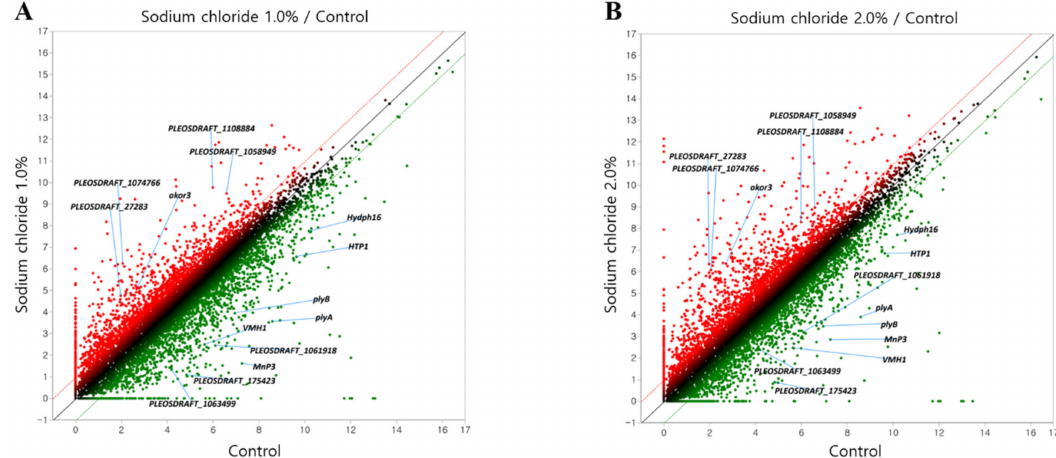
Figure 3. ( A ) DEG scatter plot analysis of control and NaCl 1.0% condition of Pleurotus ostreatus , red, 4-fold change over; green, 4-fold change lower. ( B ) DEG scatter plot analysis of control and NaCl 2.0% condition of Pleurotus ostreatus , red, 4-fold change over; green, 4-fold change